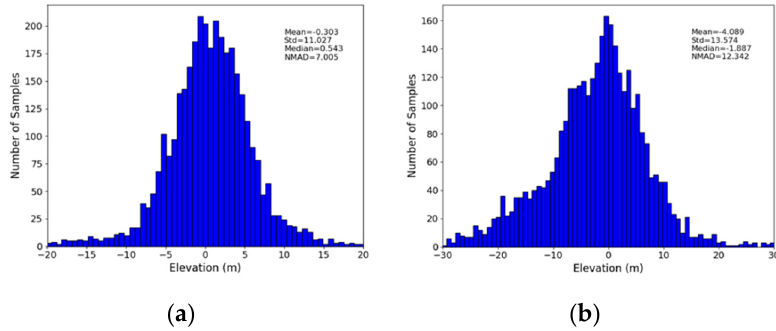
Figure 13. Histogram distribution and statistics of elevation differences between ( a ) 2019 Planetscope DEM and Ge-1 and WV-2 DEM ( b ) 2017 DEM PlanetScope and SRTM.